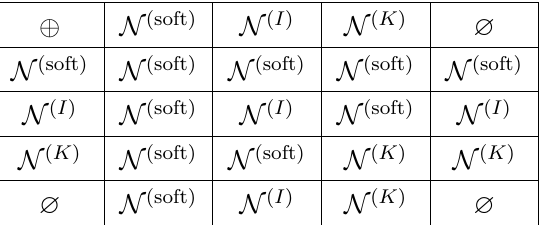
Table 3. Table for the operation (cid:8) , in the notations of eqs. (3.2) and (3.3), with I and K labelling di(cid:11)erent